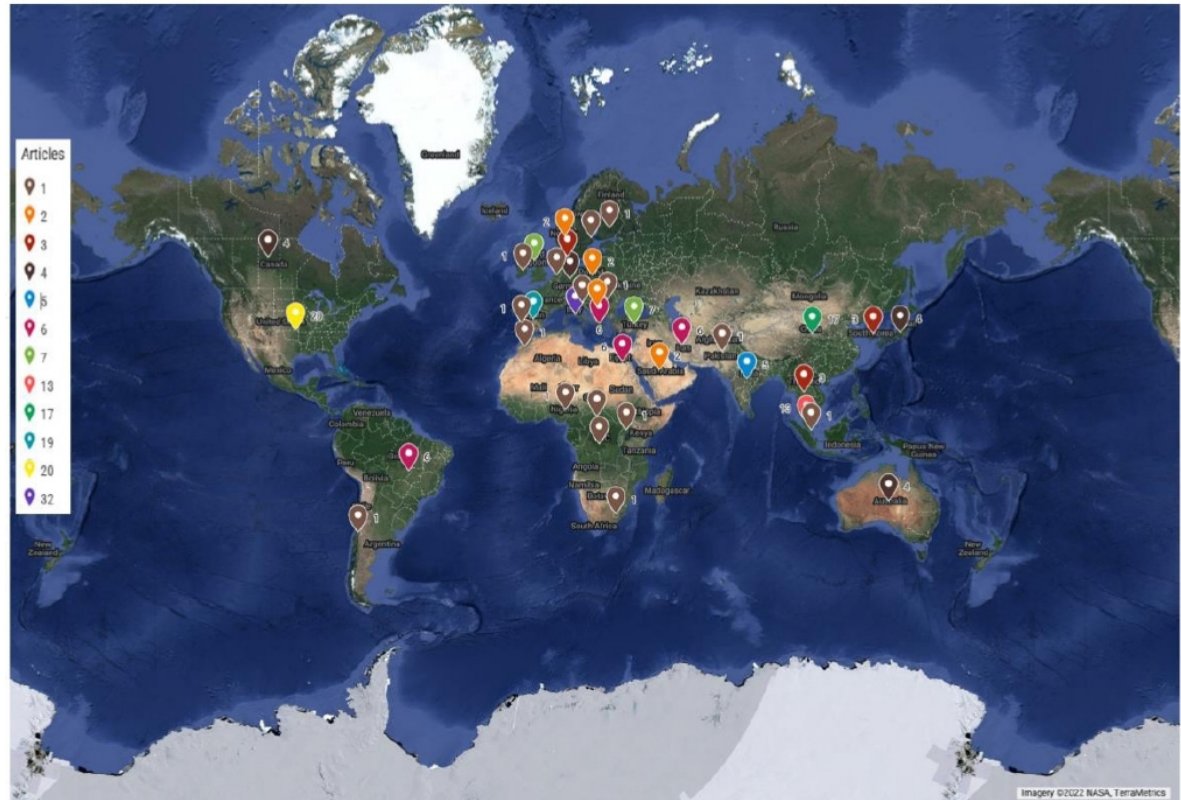
Figure 3. Visual capture of the examined 185 articles (the studies refer to 39 countries) on a global map image.